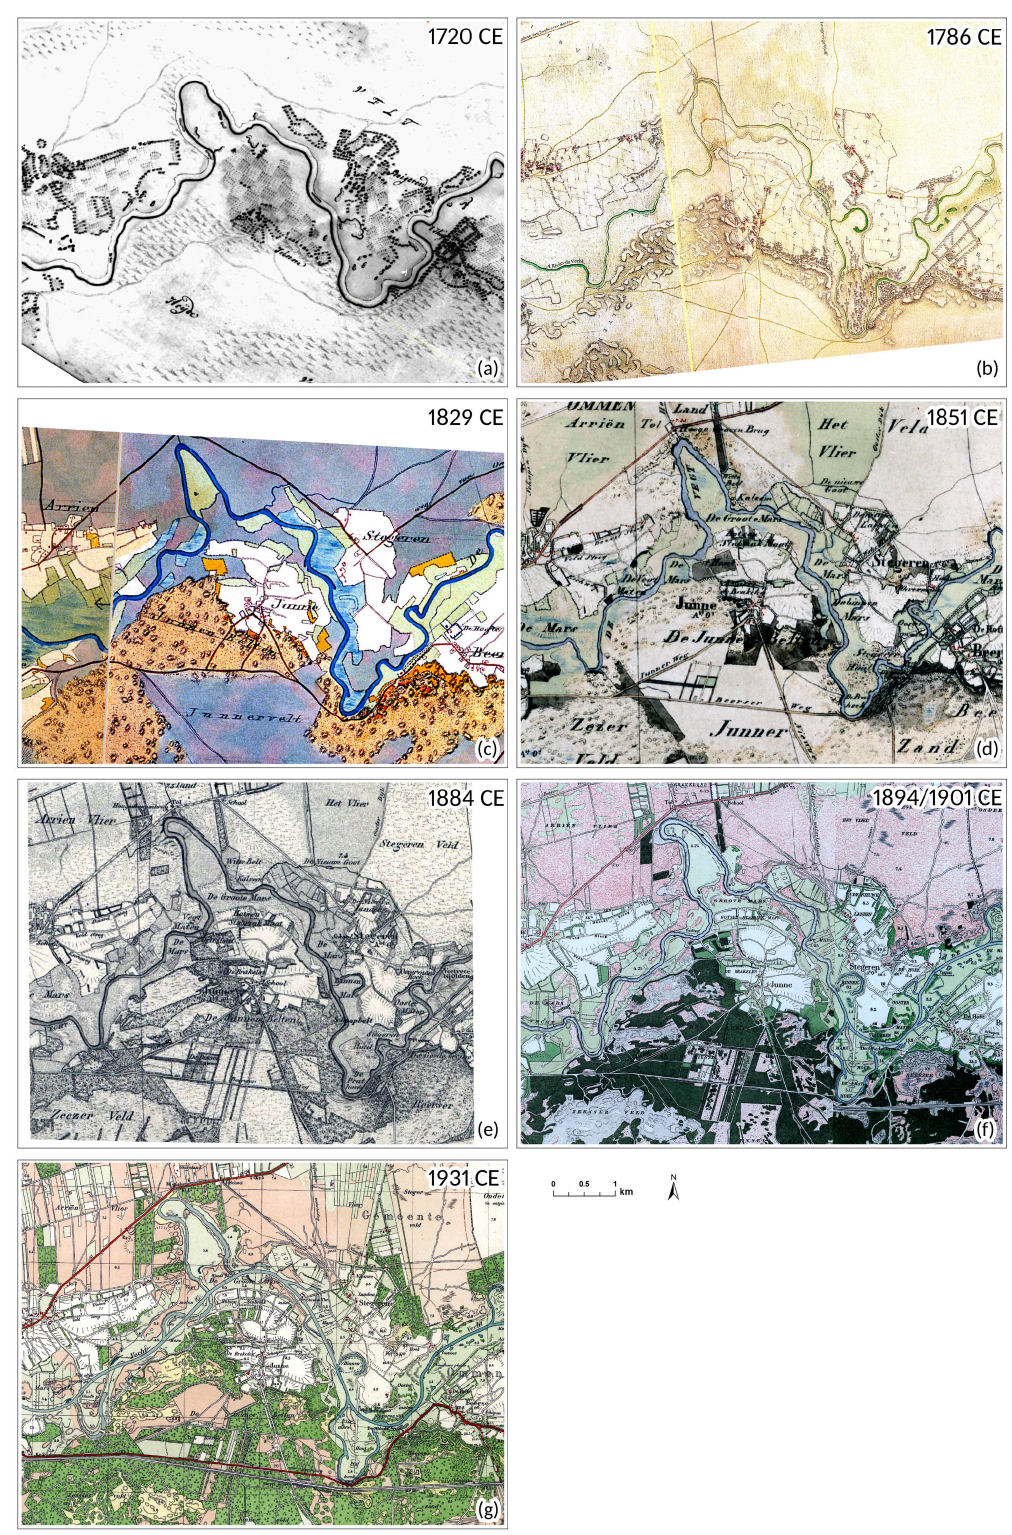
Figure 2. (a–e) Sections of historical maps displaying the study area (for explanation refer to Table 1); (g) map showing the same area in 1931 CE (publication date). As section (f) consists of two map sheets two dates are listed (details in Table 1). Image references: (a) Algemeen Rijks Archief, Genie-archief, situatiekaart 07; (b) Versfelt (2003); (c) Versfelt and Schroor (2005); (d) CC-BY Kadaster (2018a); (e) CC-BY Kadaster (2018b); (f) CC-BY Kadaster (2018c); (g) CC-BY Kadaster